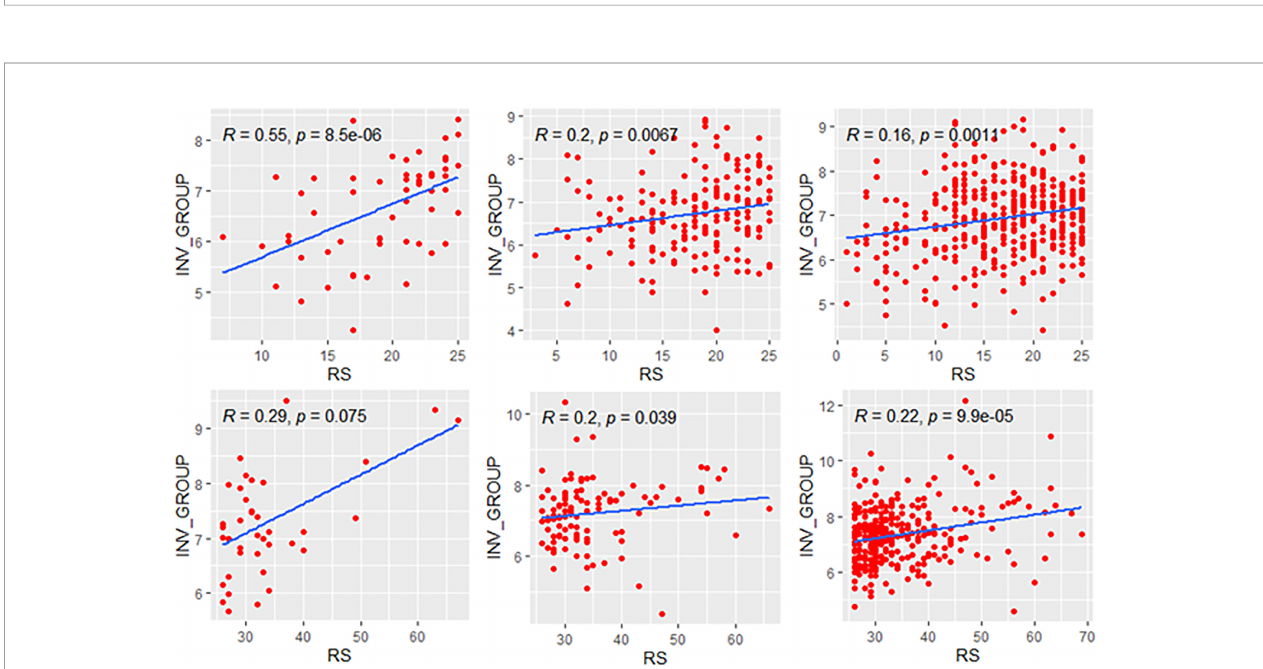
FIGURE 4 | Relationships of the RS with its proliferation module. The upside and downside ranks showed the relationship in patients with RS ≤ 25 and RS >25, respectively. Groups A, B, and C were presented from left to right. RS, recurrence score; PROL,